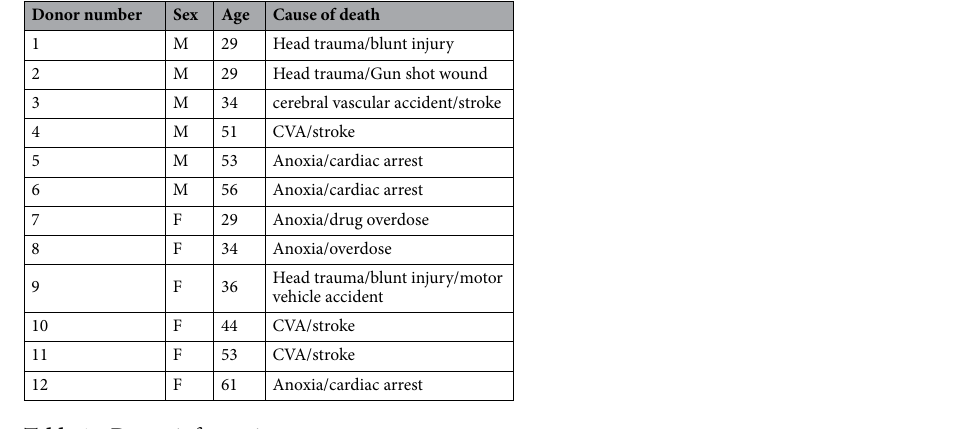
Table 1. Donor information.